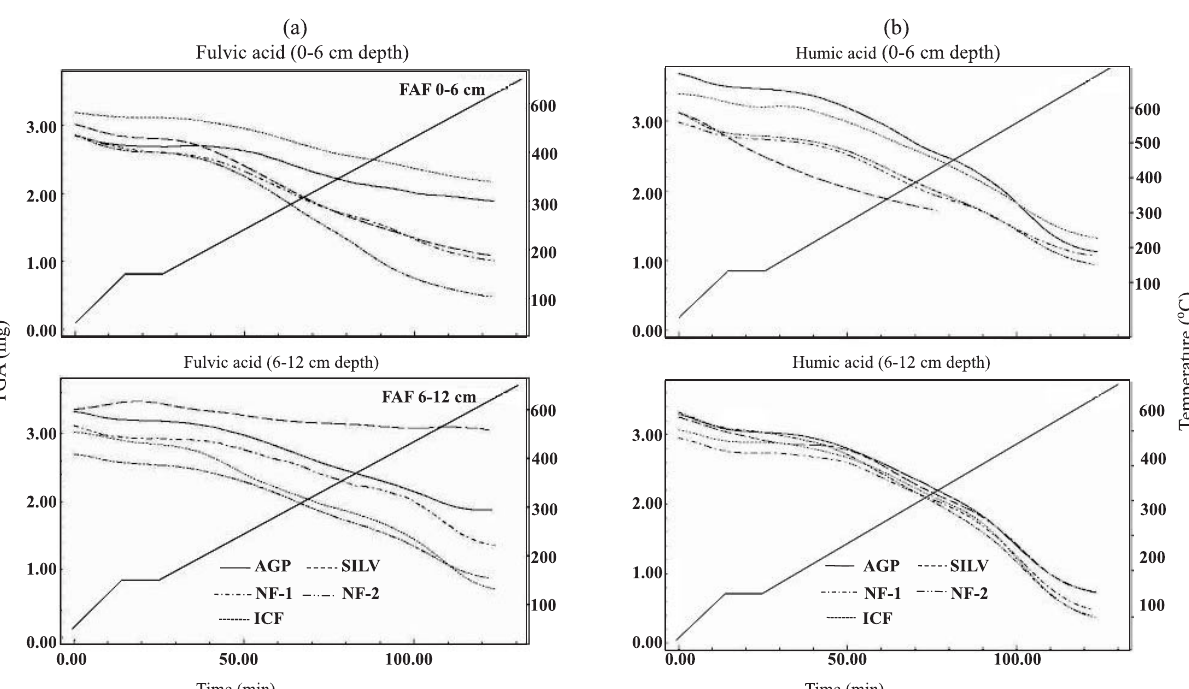
Figure 3. Thermograms of fulvic acid (a) and of humic acid (b) extracted from the 0–6 and 6–12 cm layers of a Chromic Luvisol under agroforestry, intensive cultivation, and native forest. AGP: agrosilvopasture; SILV: silvopasture; ICF: intensive cultivation under fallow; NF-1: native forest compared to AGP and SILV treatments; NF-2: native forest compared to the ICF